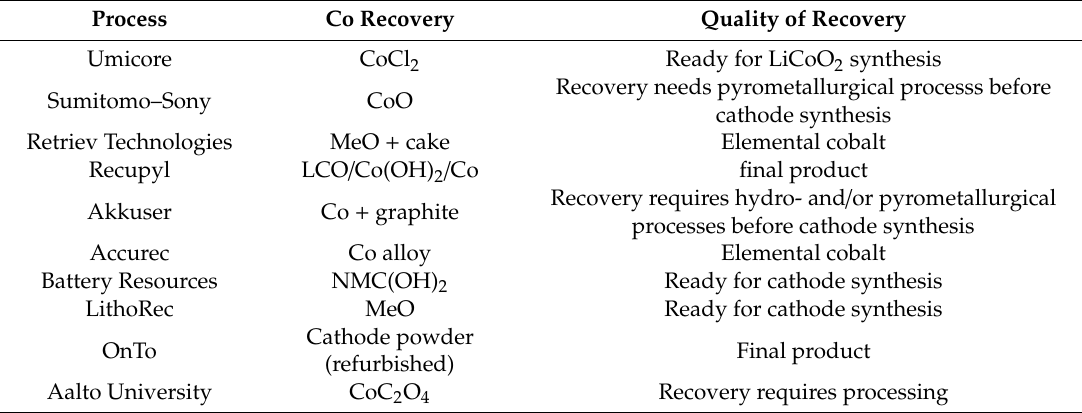
Table 3. Cathode material recovery summary of the recycling